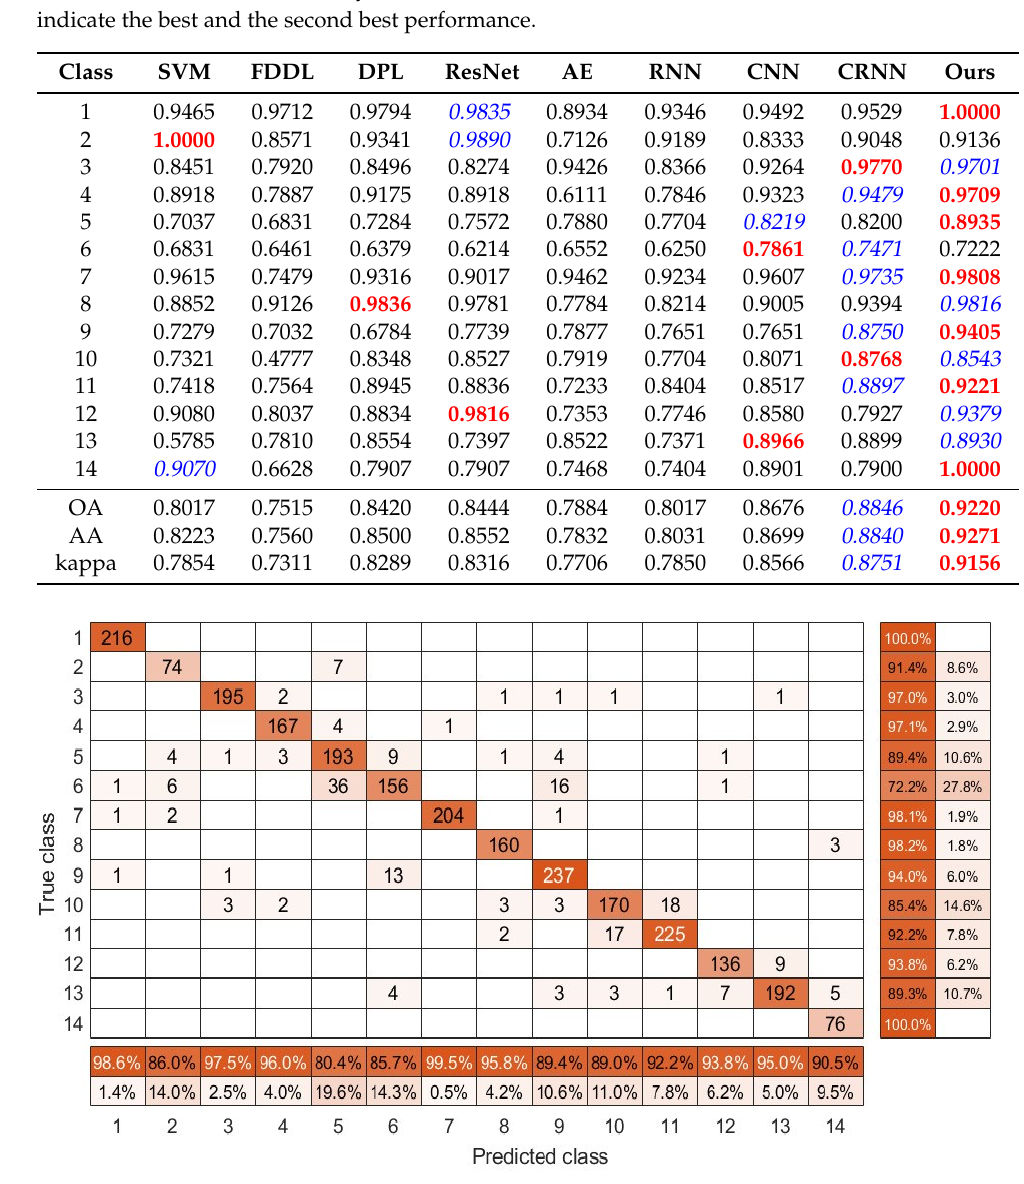
Figure 9. Confusion matrix of the developed model on the Botswana